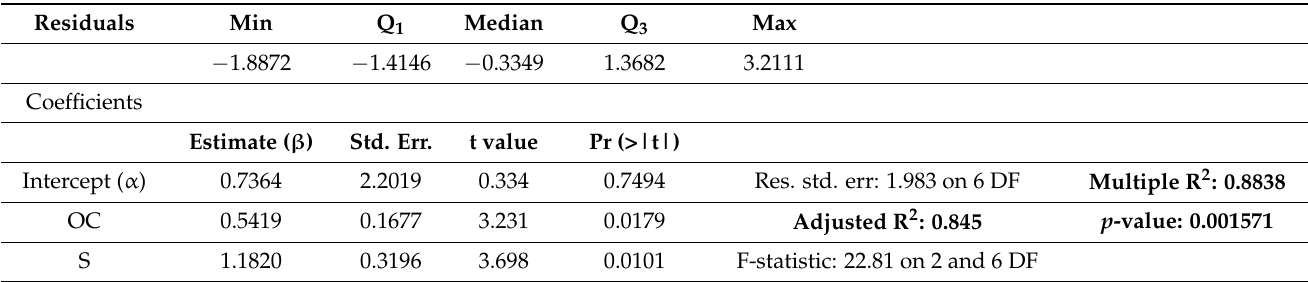
Table 7. Multiple linear regression of the two-factor